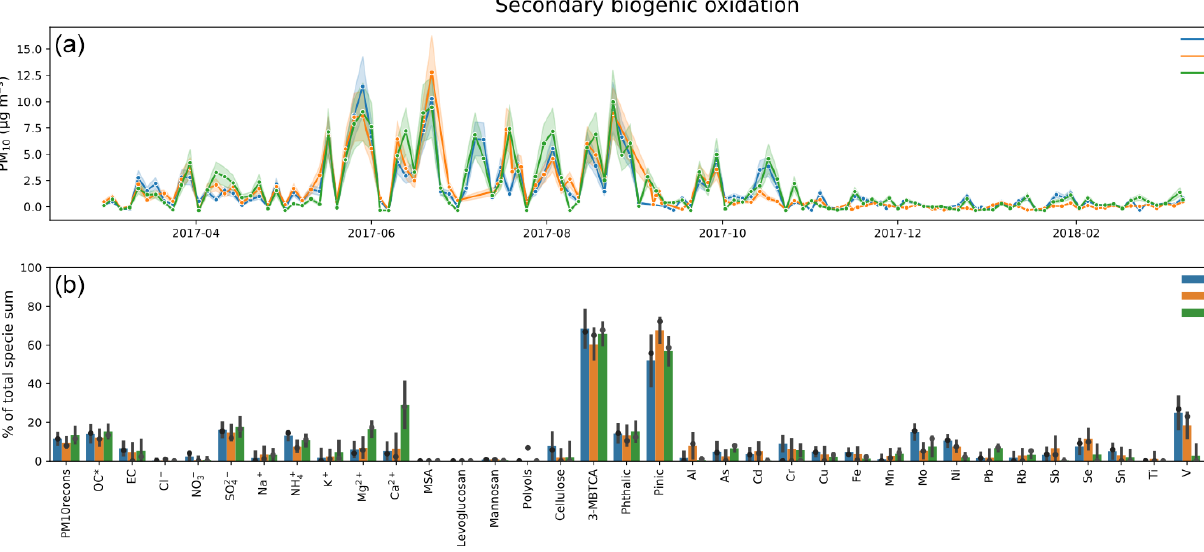
Figure 6. Secondary biogenic oxidation factor for the three urban sites. (a) Contribution to PM 10 given the mean and standard deviation of the 100 BS. (b) Percentage (%) of each species apportioned by this factor (dots refer to the constrained run, bar plots refer to the mean, and error bars refer to the standard deviation of the 100